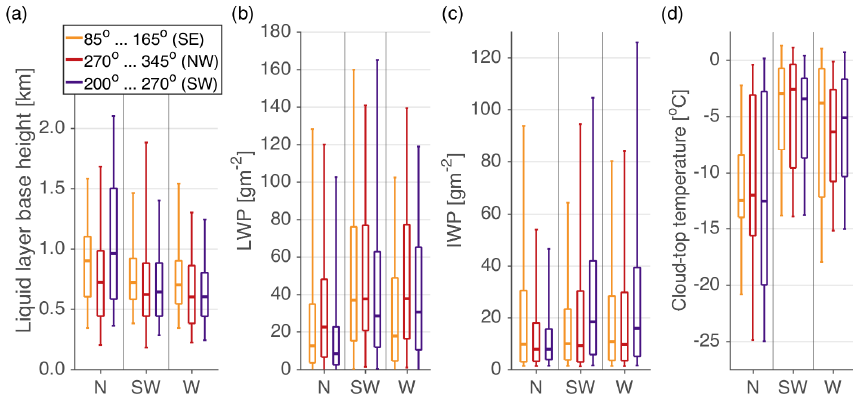
Figure A1. P-MPC liquid layer base height (a) , LWP (b) , IWP (c) , and cloud-top temperature (d) distributions for selected weather types and surface wind directions. Boxes and whiskers as in Fig. 7. The medians were found to differ (on a 95% confidence level) in LWP for N and W and IWP for SW and W.